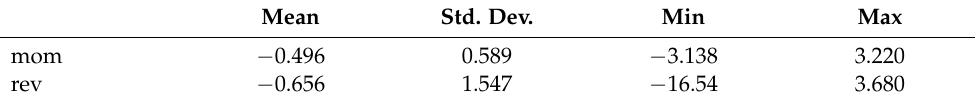
Table 1. Cont. Mean Std. Dev. Min Max mom − 0.496 0.589 − 3.138 rev −